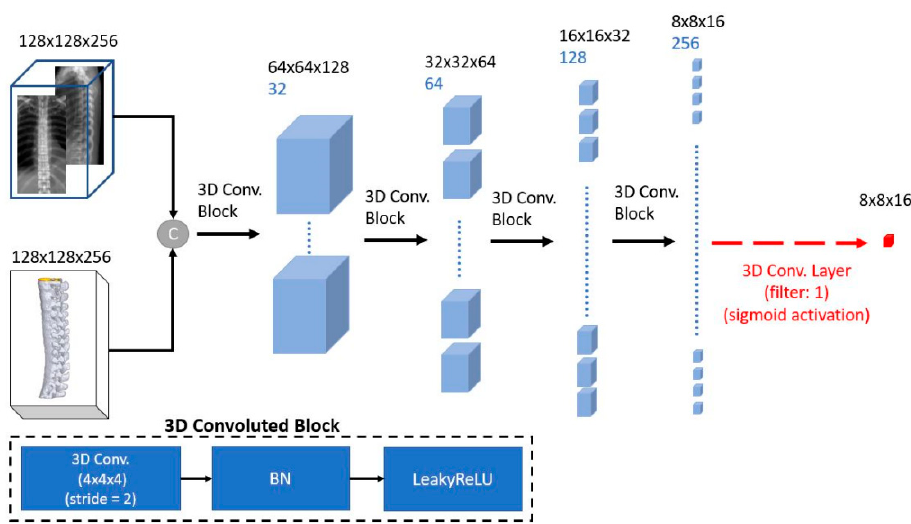
Figure 4. Three-dimensional-patch-GAN Discriminator. Circle C: Concatenate. The input combined conditional volume (orthogonal X-ray images) and generated 3D spine volume. Then, it was sent to the 3D Patch-GAN with four 3D convolution blocks for loss calculation.